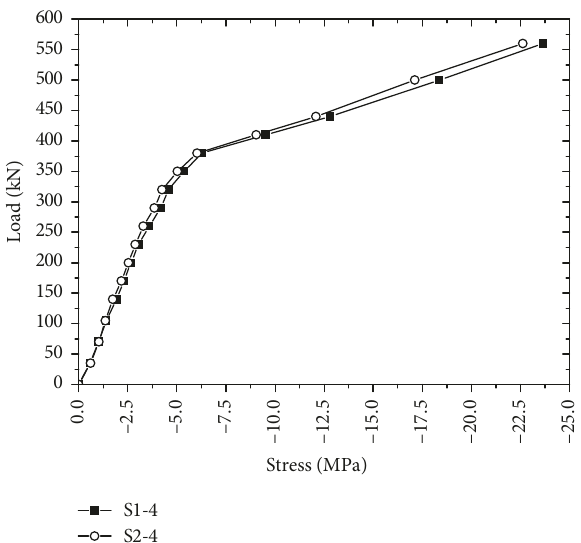
Figure 12: Load-stress curve at the midspan roof of the hollow slab.